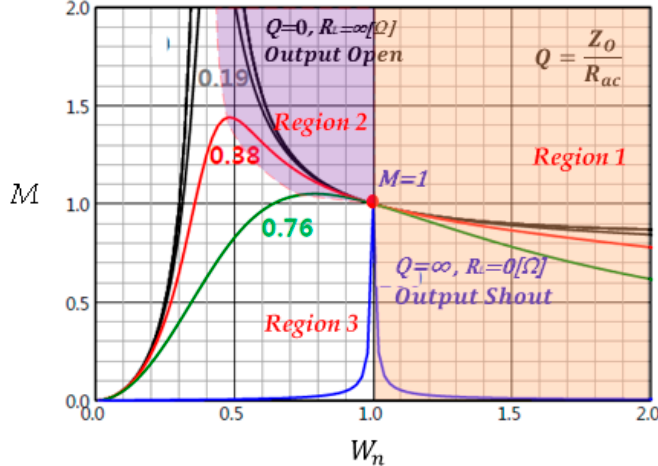
Figure 6. Input–output voltage gain and frequency characteristic graph of the resonant converter.